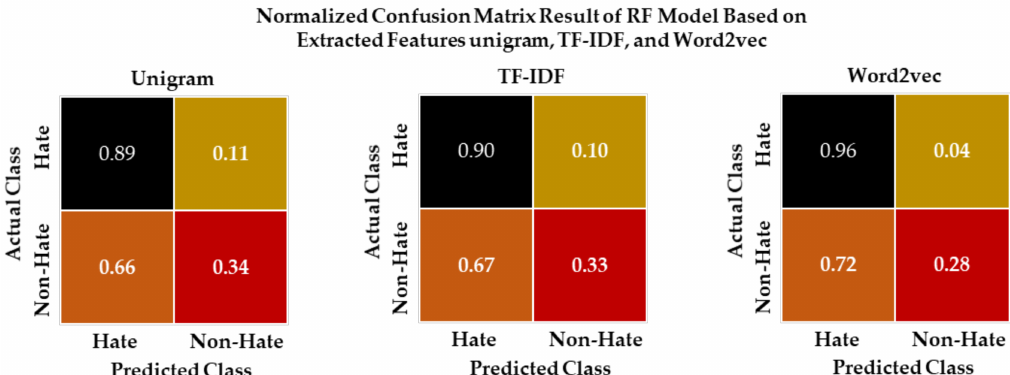
Figure 8. Confusion matrix of sample binary RF models based on extracted